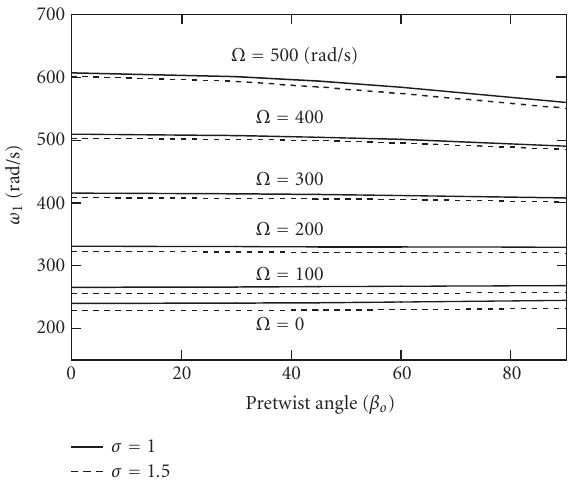
Figure 5: Variation of the second coupled flapping-lagging fre- quency versus plyangle for selected rotating speeds Ω (rad/s), and three di ff erent taper ratios ( γ = β = 0).